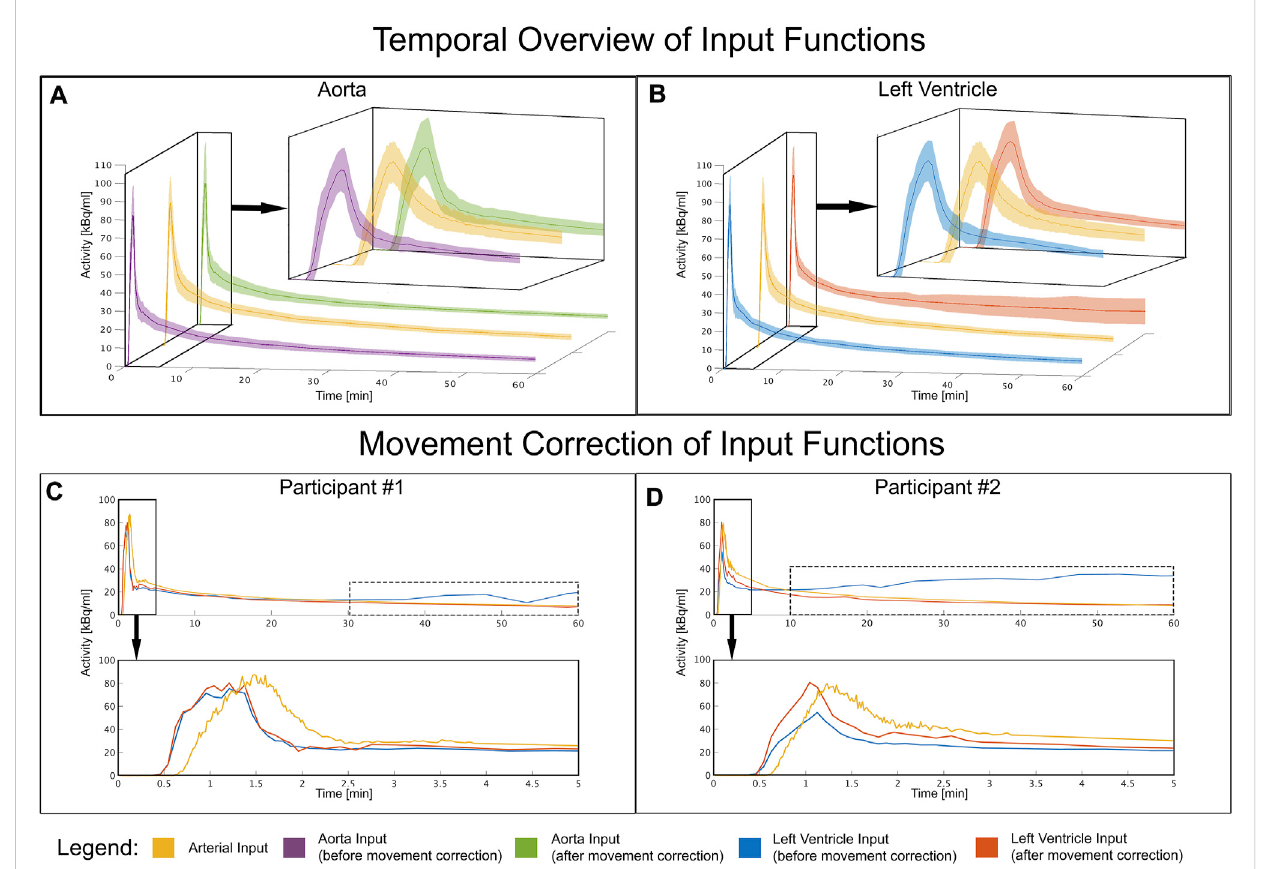
FIGURE 3 Temporal overview of each input function: ( A) Mean and standard deviation time course of the image derived input function before and after movementcorrectionincomparisontothearterialinputfunctionofallparticipants.Theaortashowsastableandconcurrentinputfunctioncomparedto arterial blood both before and after movement correction. (B) Mean and standard deviation time course extracted from the left ventricle for all participants (C – D) Shows the input functions of two participants affected by movement problems. Towards the end of the measurement, the variance increases due to movement which is indicated by the dotted box. This was corrected by applying movement correction. Time course extracted from the left ventricle of two very movement intense participants and how motion correction counters these effects, to better match the arterial input